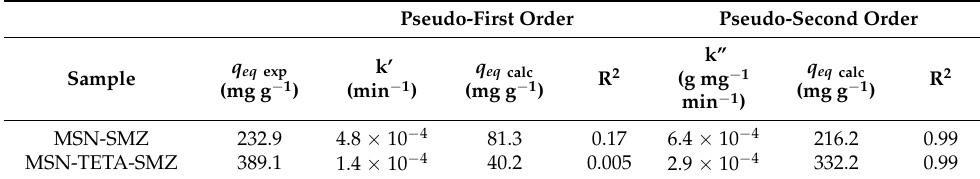
Figure 5. ( A ) Adsorption kinetics of SMZ on MSN and MSN-TETA fitted with ( B ) pseudo-first order and ( C ) pseudo-second order models. Table 2. Kinetic parameters for SMZ adsorption on MSN and MSN-TETA.